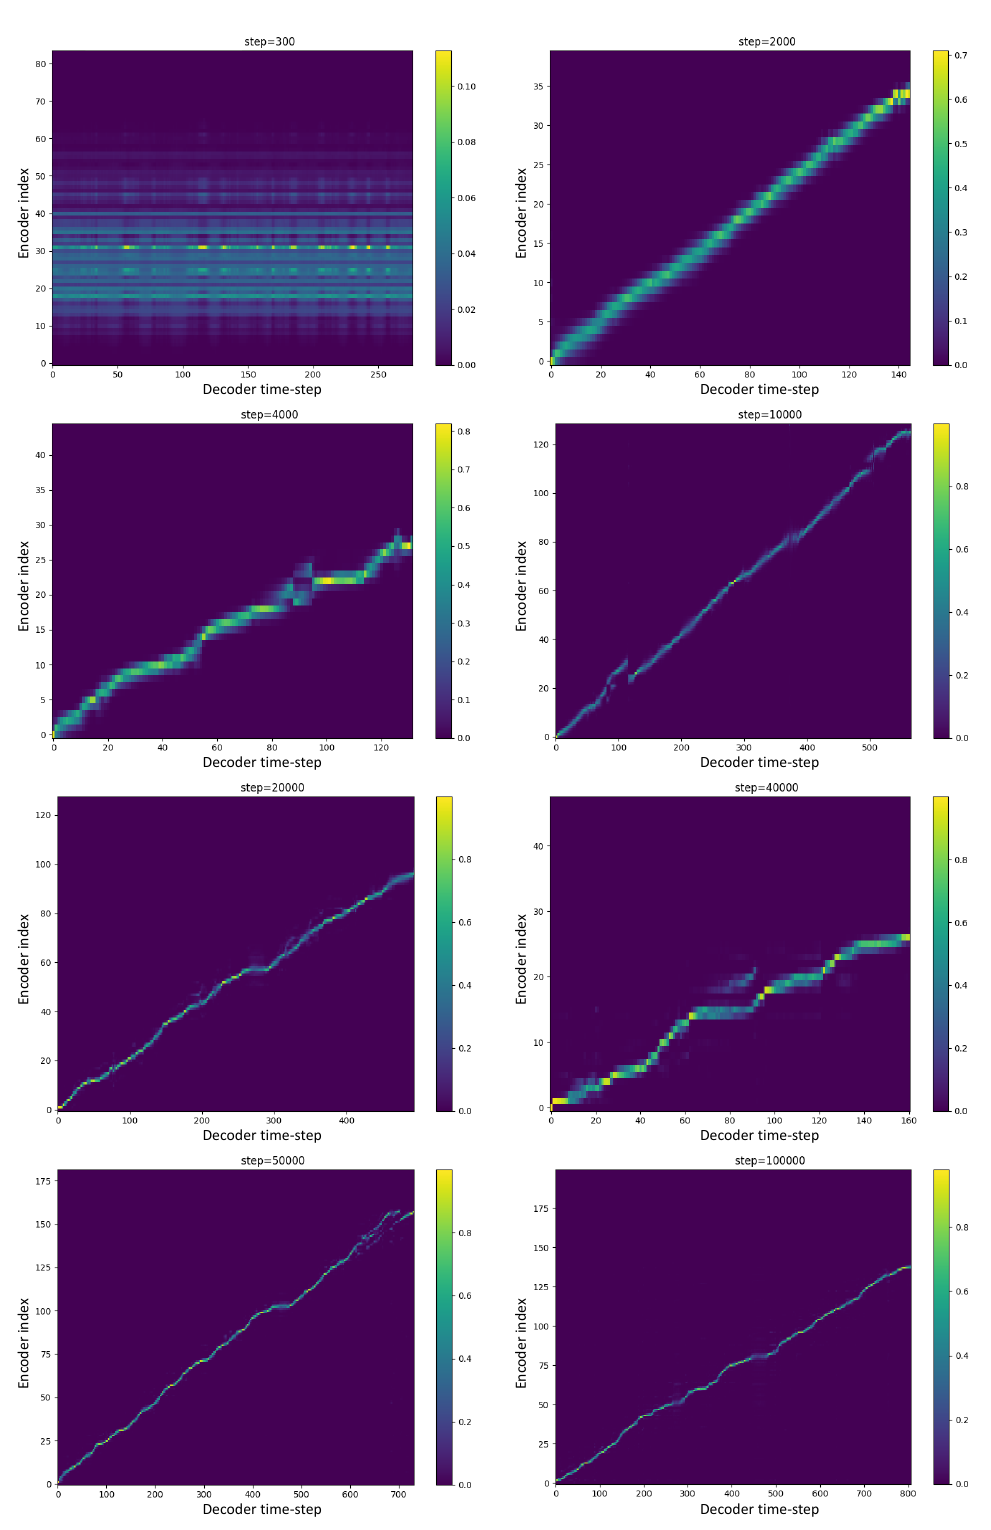
Figure A4. Attention plot during training Tacotron2-GST-GRA with decaying guided